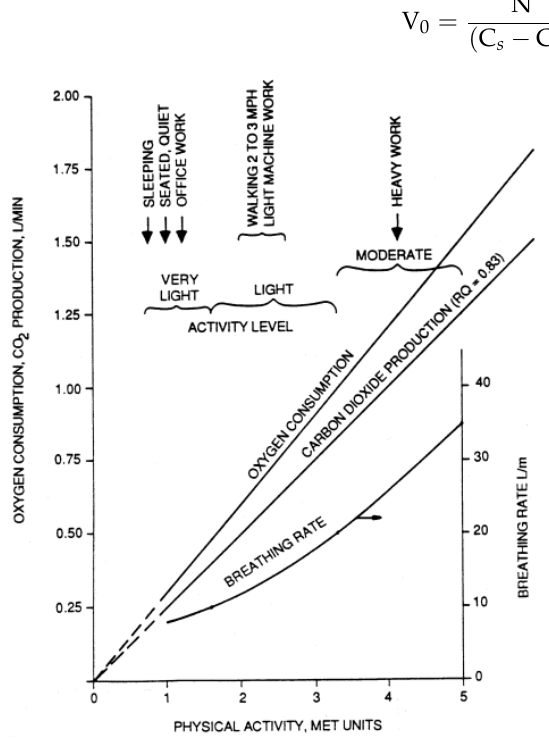
Figure 5. Oxygen consumption, carbon dioxide production and breathing rate versus physical ac- tivity in METs (metabolic equivalent task) [41]. in METs (metabolic equivalent task)